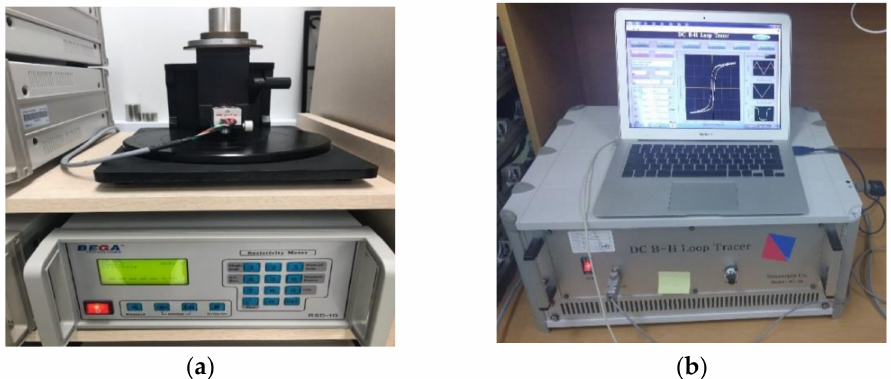
Figure 5. Conductivity and permeability measuring equipment: ( a ) Conductivity meter; ( b ) DC B-H loop